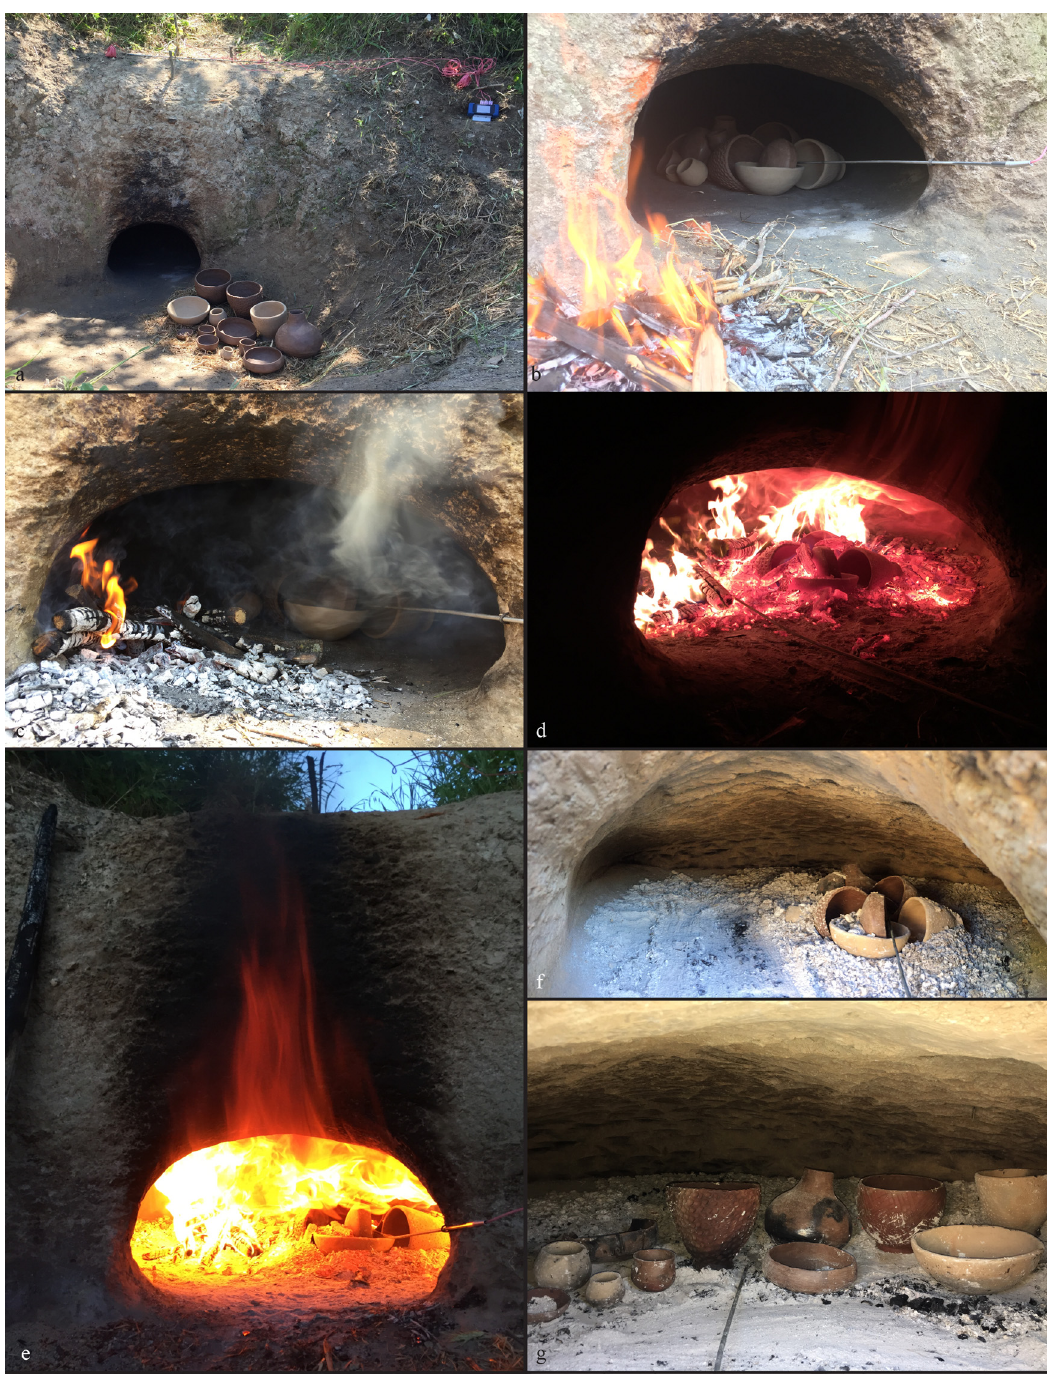
Figure 7: Oxidising pottery fi ring ( B ) . ( a ) Preparation of the experiment and setting of the thermocouples, ( b and c ) heating step, ( d and e ) fi ring, ( f ) state of oven and vessels after the cooling phase, and ( g ) fi nal